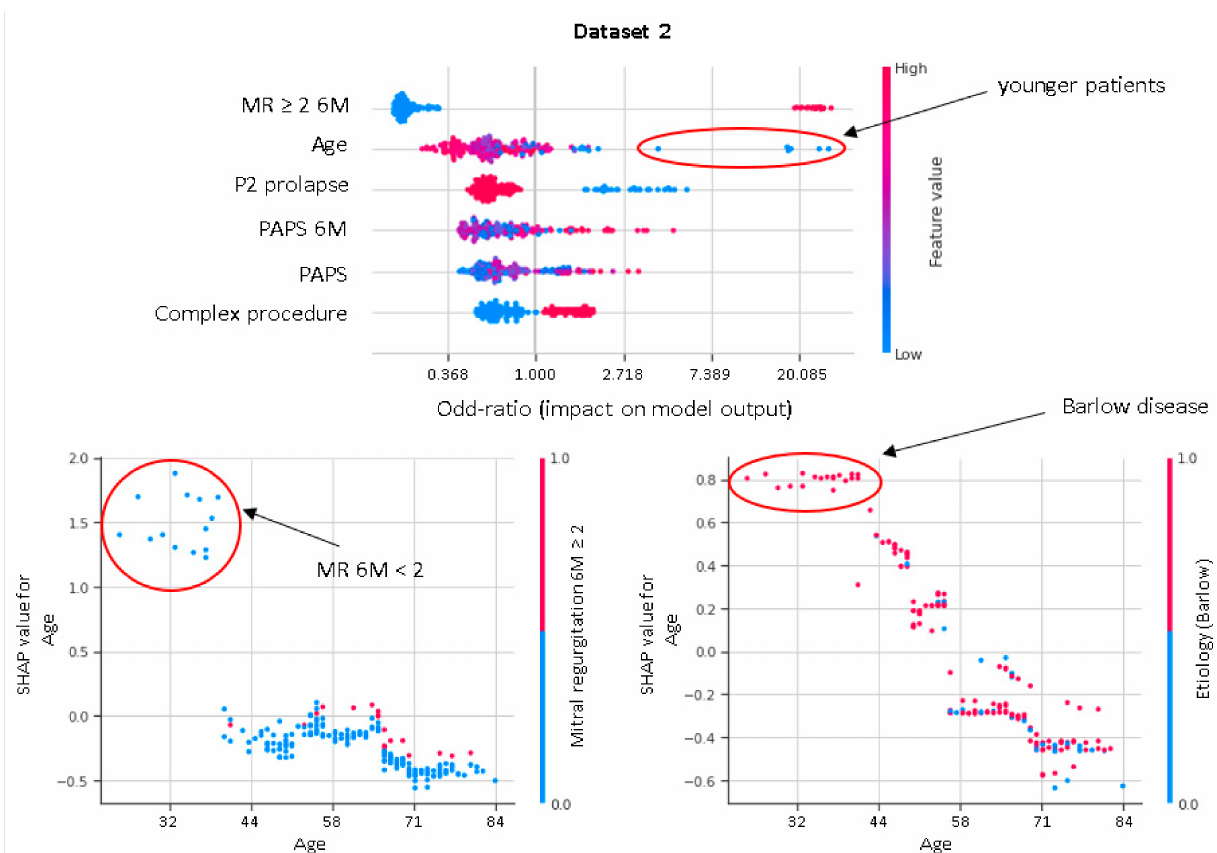
Figure 5. Shapley dependence plots. The horizontal axis shows the age. The color indicates whether the value of the second feature, which may have an interaction effect with the age, is high (red) or low (blue) for a given